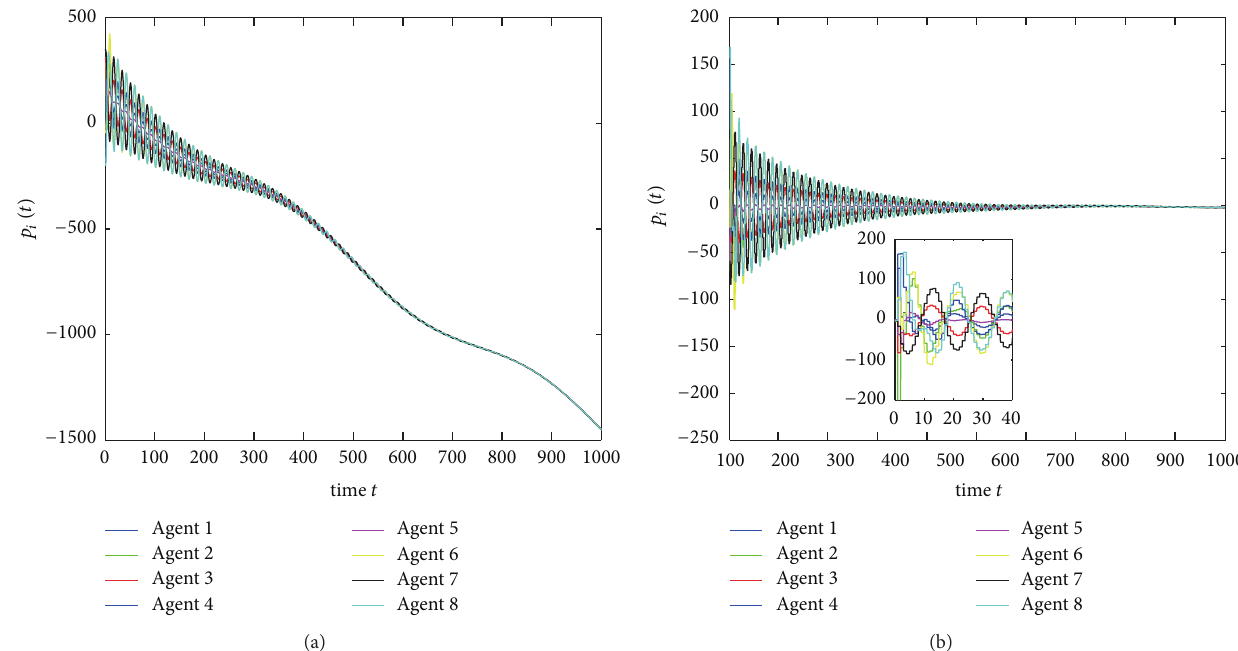
Figure 4: Trajectory of controlled multiagent system (3) with communication graph shown in Figure 1, where 𝛽 1 = 0.3 , 𝛽 2 = 0.05 , 𝛼 = 1 . Evolution of (a) 𝑝 𝑖 and (b) V 𝑖